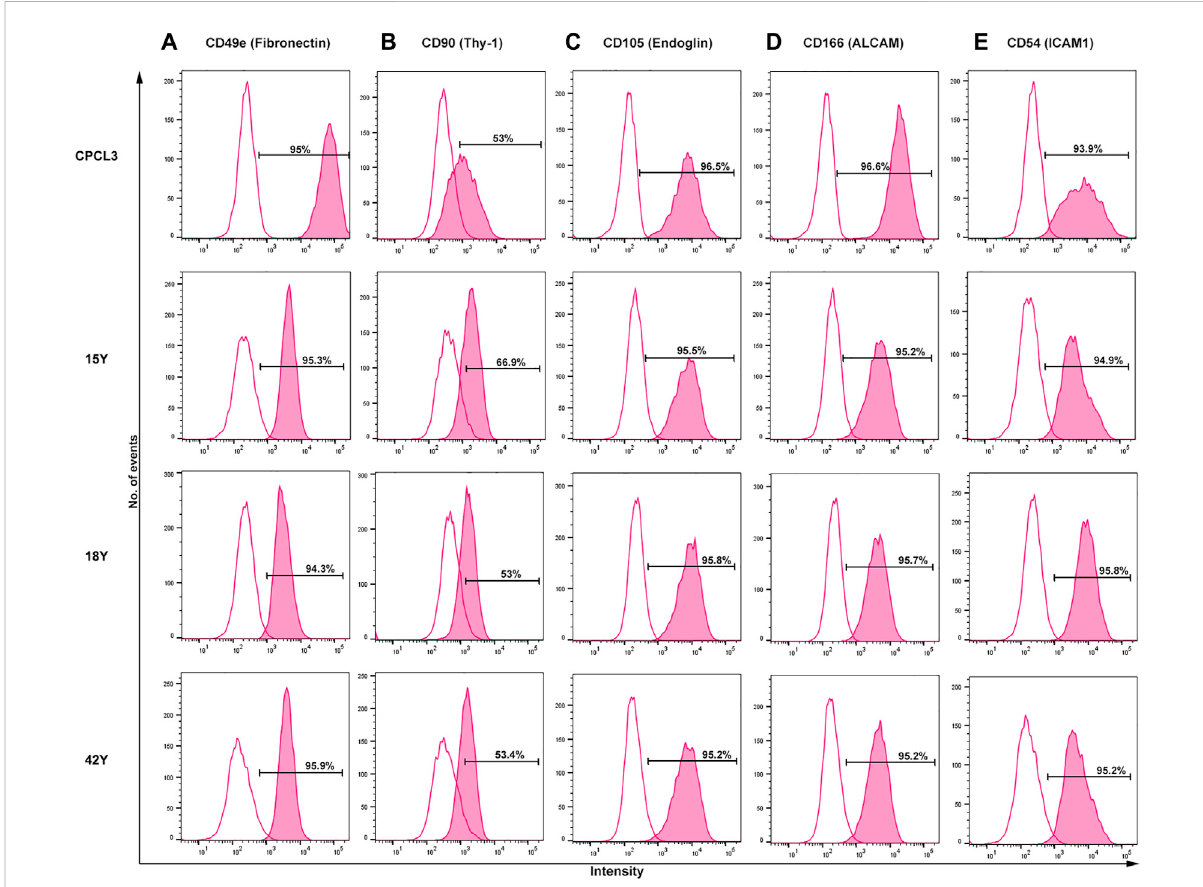
FIGURE 1 Side-by-side comparison of the cell surface marker pro fi les of the stable CPC line (CPCL3) and primary CPCs. Cell surface marker expression rates of (A) Fibronectin, (B) Thy-1, (C) Endoglin, (D) ALCAM, and (E) ICAM1 in CPCL3 and three primary CPC cell sources. Primary CPCs were independently collected and analyzed from three different individuals: 15-, 18-, and 42-years-old patients with no signs of degenerative joint diseases, such as osteoarthritis or rheumatoid arthritis. The empty peaks represent isotypic controls, for reference. Percent values indicated in the graphs represent positive staining rate, above isotype control, for each individual CD